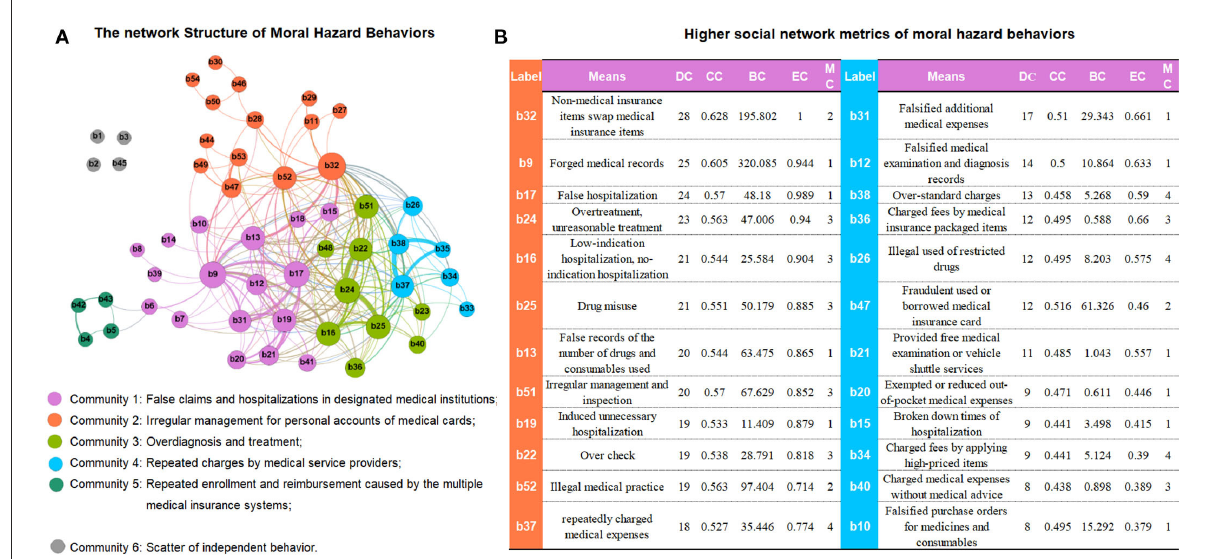
FIGURE3 (A,B) The network structure of moral hazard behaviors in medical insurance fund and higher social network metrics of moral hazard behaviors. DC, degree centrality; CC, closeness centrality; BC, betweenness centrality; EC, Eigenvector Centrality; MC, modularity class. Whole detail in Supplementary File